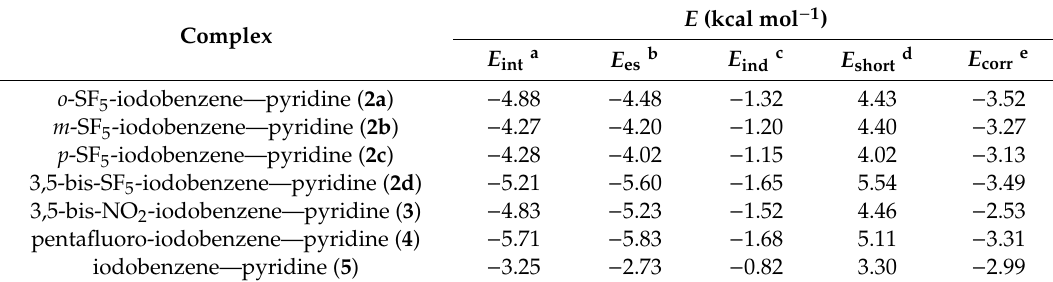
Table 1. Electrostatic, induction, and dispersion energies of halogen-bonded complexes a . E (kcal mol − 1 ) Complex E int a E es b E ind